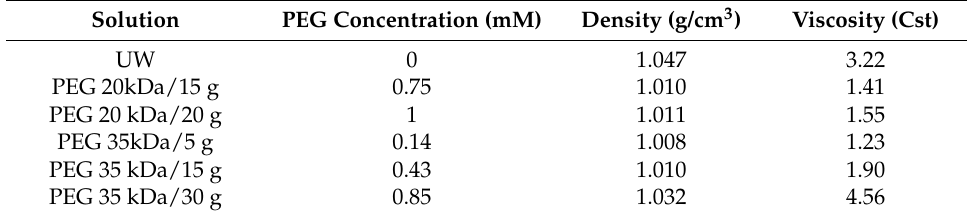
Table 1. Physical properties of the different preservation